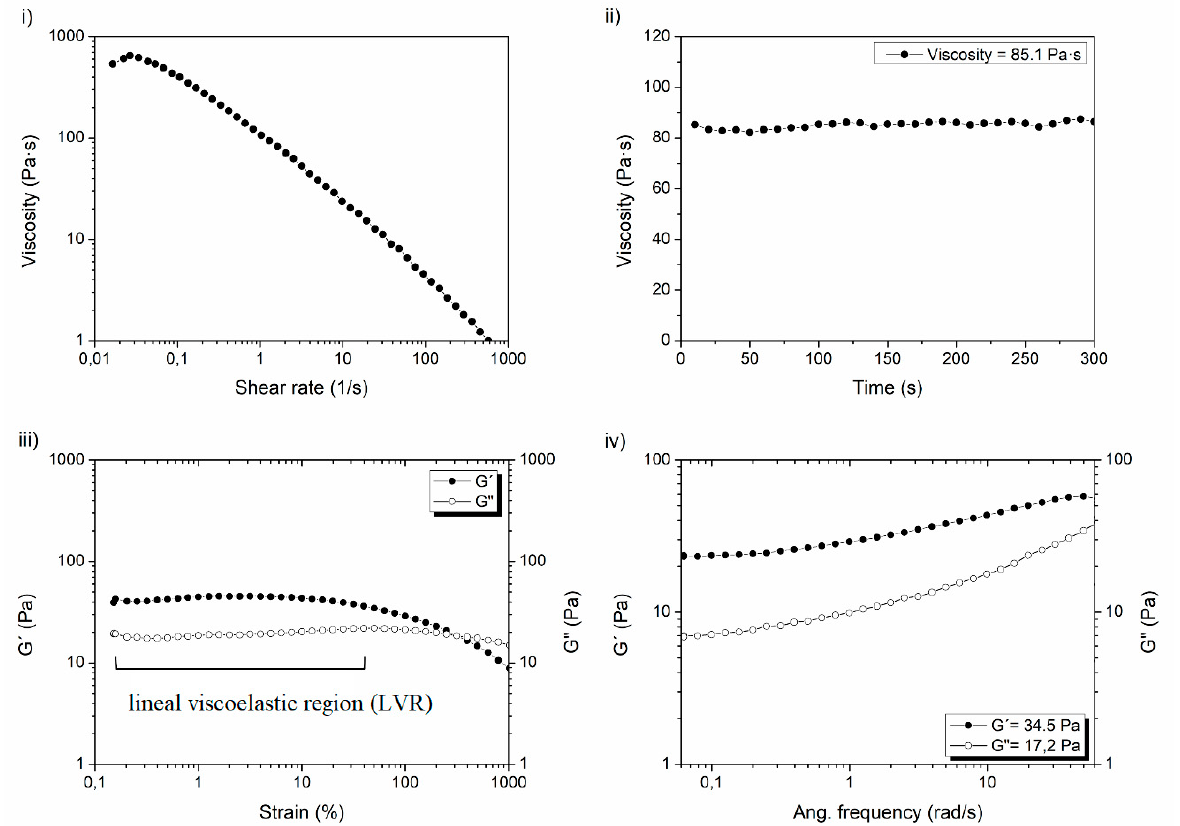
Figure 3. Steps of proposed protocol for standardization of the rheological characterization of injectable hydrogels: ( i ) determination of viscosity vs shear rate; ( ii ) viscosity vs time; ( iii ) elastic modulus (G ′ ) and viscous modulus (G ″ ) vs strain; ( iv ) elastic modulus (G ′ ) vs Ang. frecuency.